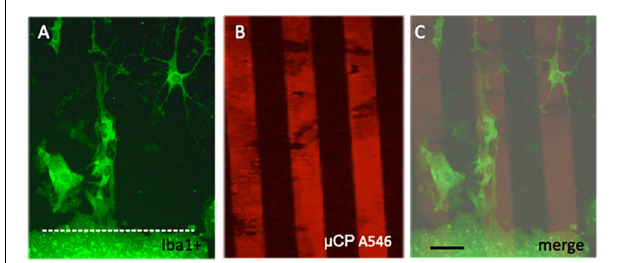
FIGURE 2 | Migration of microglia along microcontact prints ( µ CP). Cortex brain slices were cultured on collagen-monocyte chemoattractant-protein-1 loaded µ CP for 3 weeks and then fixed and stained for the microglial marker Iba1 (stained with Alexa-488, fluorescent green) (A) . As a loading control red fluorescent (Alexa-546 anti-goat) microprints were connected to the slice (B) . The merged picture (C) clearly shows that Iba1+ microglia migrated along the collagen µ CP lanes. The slice is shown at the bottom and a white dotted line (A,C) indicates the border. Note several ramified Iba1+ microglia migrating out of the brain slice. Scale bar in panel (C) = 35 µ m (A–C)